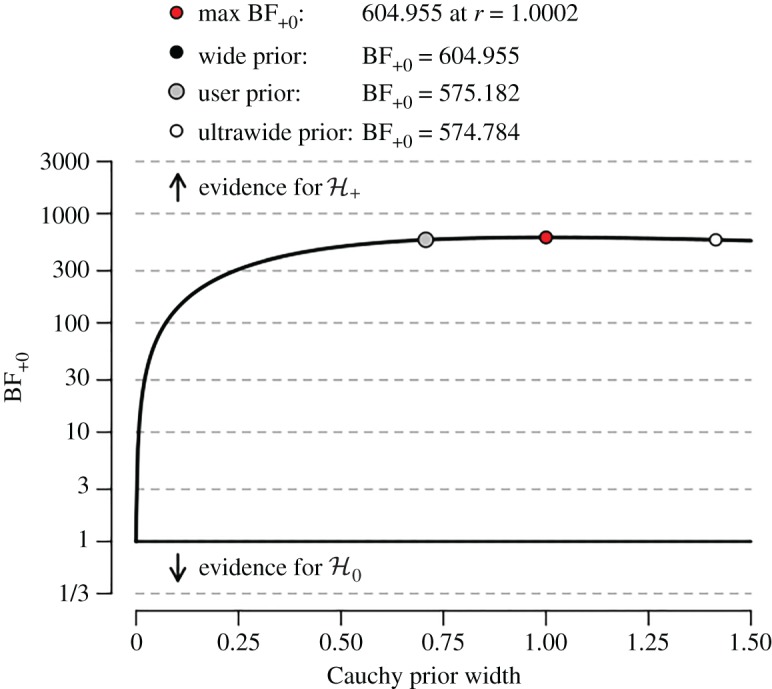
JASP robustness analysis of the t-test example featuring the first replication study reported in IJzerman et al. [33]. The evidence in favour of the directional hypothesis H+ varies as a function of the width of the prior distribution for effect size (i.e. ‘Cauchy prior width’, on the x-axis). When the width equals zero, H0 and H+ are identical and the Bayes factor is 1 regardless of the data. Here the evidence in favour of H+ is compelling, with Bayes factors exceeding 100 for all but the most narrow priors. See text for details.